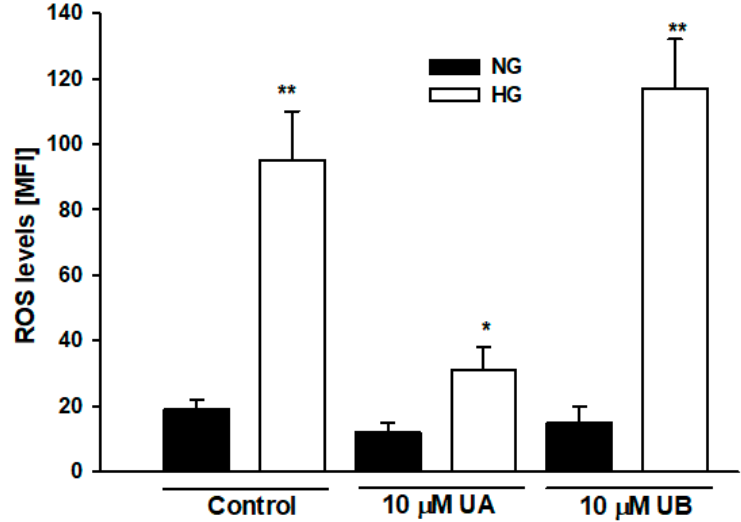
Figure 8. Urolithin A but not UB reduced reactive oxygen species (ROS) levels in podocytes exposed to high glucose. Podocytes cultured for 7 d in normal (5.5 mM, NG) or high (25 mM, HG) glucose were incubated for 24 h with 10 µM UA or 10 µM UB. ROS were detected by flow cytometry using CellROX Green reagent. Results show mean ± SEM. Mann–Whitney test was used to calculate p values. * p < 0.05 vs. HG Control, ** p < 0.01 vs. NG Control ( n = 4). MFI: mean fluorescence intensity.